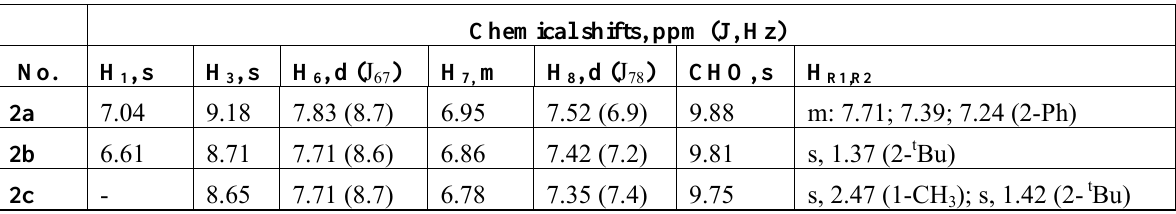
Table 2. 1 H-NMR spectra of 5-formyl indolizines 2a-c